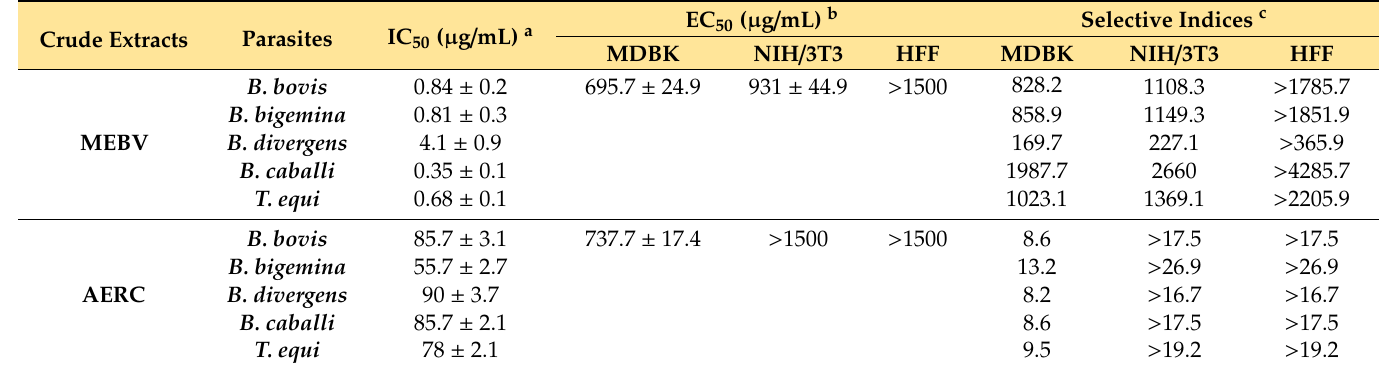
Table 3. IC 50 and selective index values of MEBV and